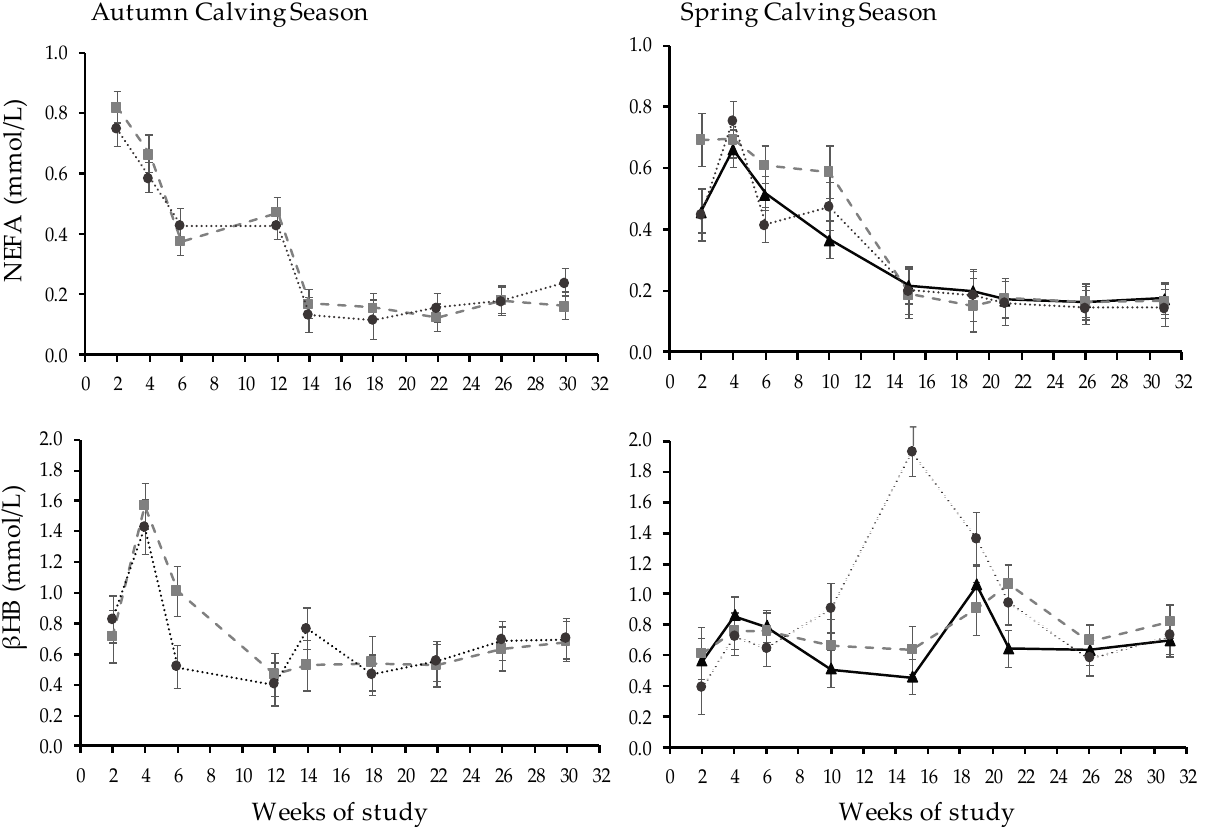
Figure 4. Patterns of non-esterified fatty acids (NEFA, mmol/L) and beta-hydroxybutirate ( β HB, mmol/L) plasma levels in autumn and spring calving seasons in confined ( ) and mixed systems with low ( ) or high ( ) environmental exposure. The BCS patterns during complete lactation adjusted for BCS at calving (3.05 ± 0.27) were affected by WOS for all treatments (Figure 3) but did not differ between treatments (2.67 vs. 2.69 ± 0.02).